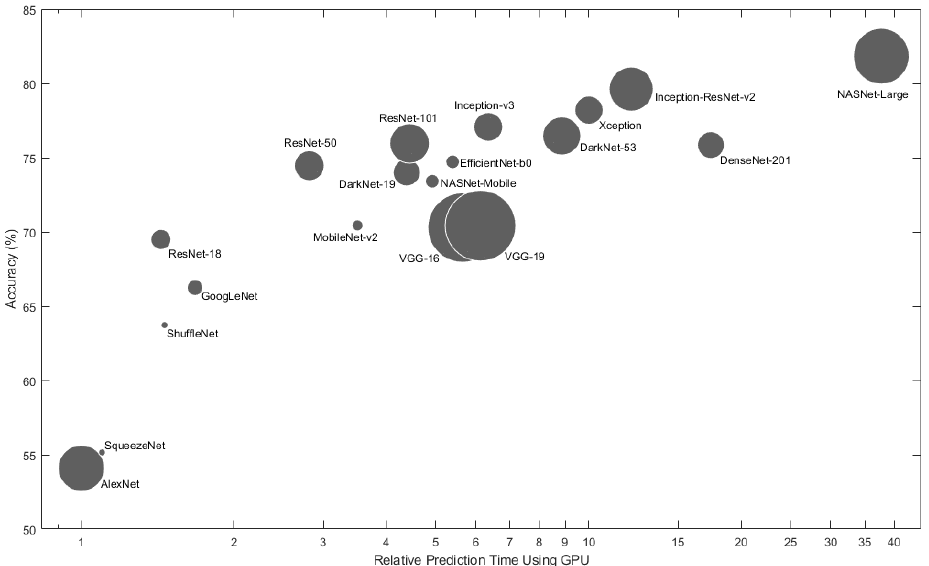
Figure 3. The comparison of speed versus the prediction accuracy of various classification neural networks. Source—www.mathworks.com (accessed on 31 January